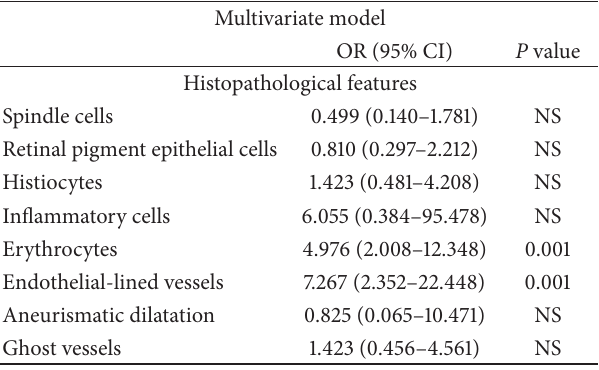
Table 3: Multivariate logistic regression analysis of diabetes mellitus in vitreous samples, estimation of odds ratio in the presence of different histopathological